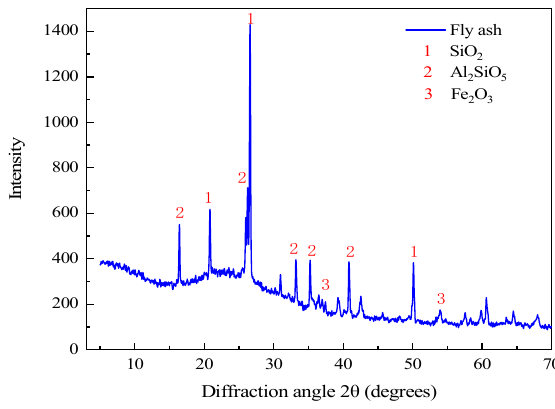
Figure 2. Qualitative analysis of fly ash XRD diffraction.